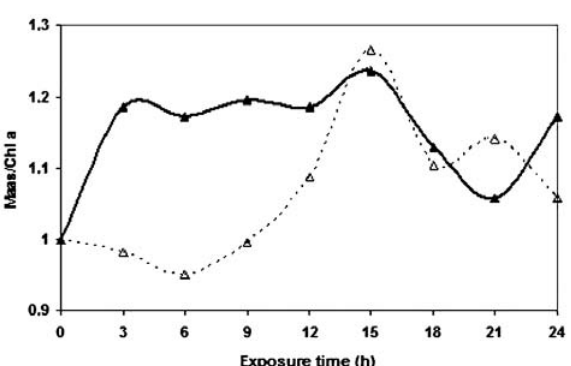
Fig . 6. – MAA/Chl a ratios (normalized to initial values) during ex- posures: Sfixed surface (filled triangles) and vertical mixing (open triangles).